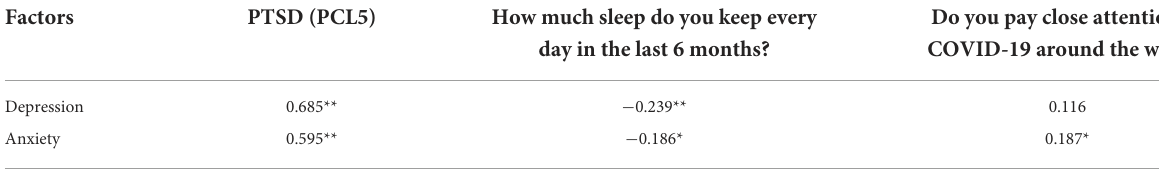
TABLE 5 Correlations of PTSD and behavior response with depression and anxiety.